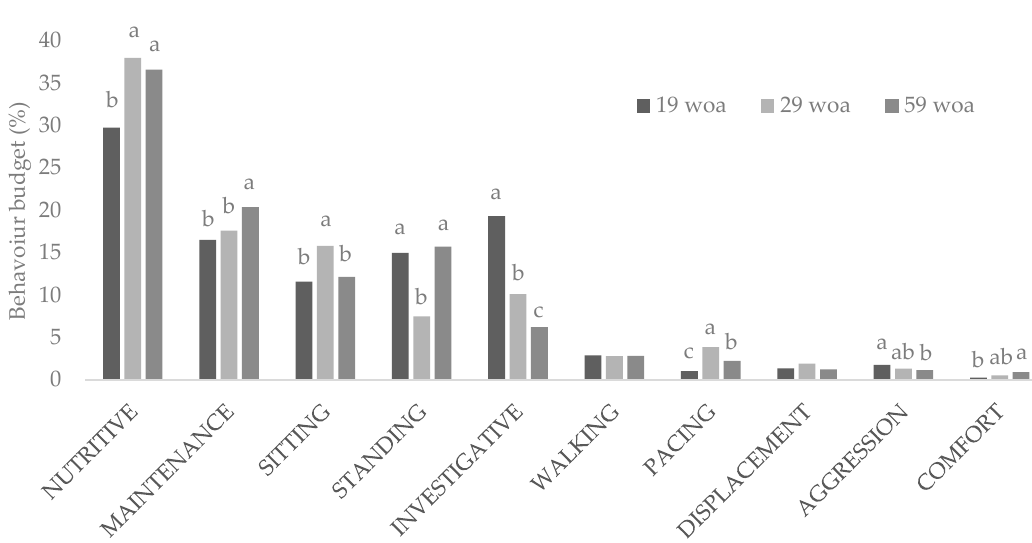
Figure 1. Percentage of time laying hens housed in conventional cages performed each behaviour category during the photophase at 19, 29 and 59 weeks of age. Behavioral categories analyzed included: nutritive (feeding and drinking behaviors), maintenance (preening, sham ‐ dustbathing, ruffling), sitting (sitting and sleeping), standing, investigative (gentle feather pecking and object pecking), walking, displacement, aggression (aggressive pecking, severe pecking and fighting), and comfort (wing or leg stretching, flapping and tail wagging). Woa: week of age. a,b,c: letters indicate time differences in the incidence of the behaviour.